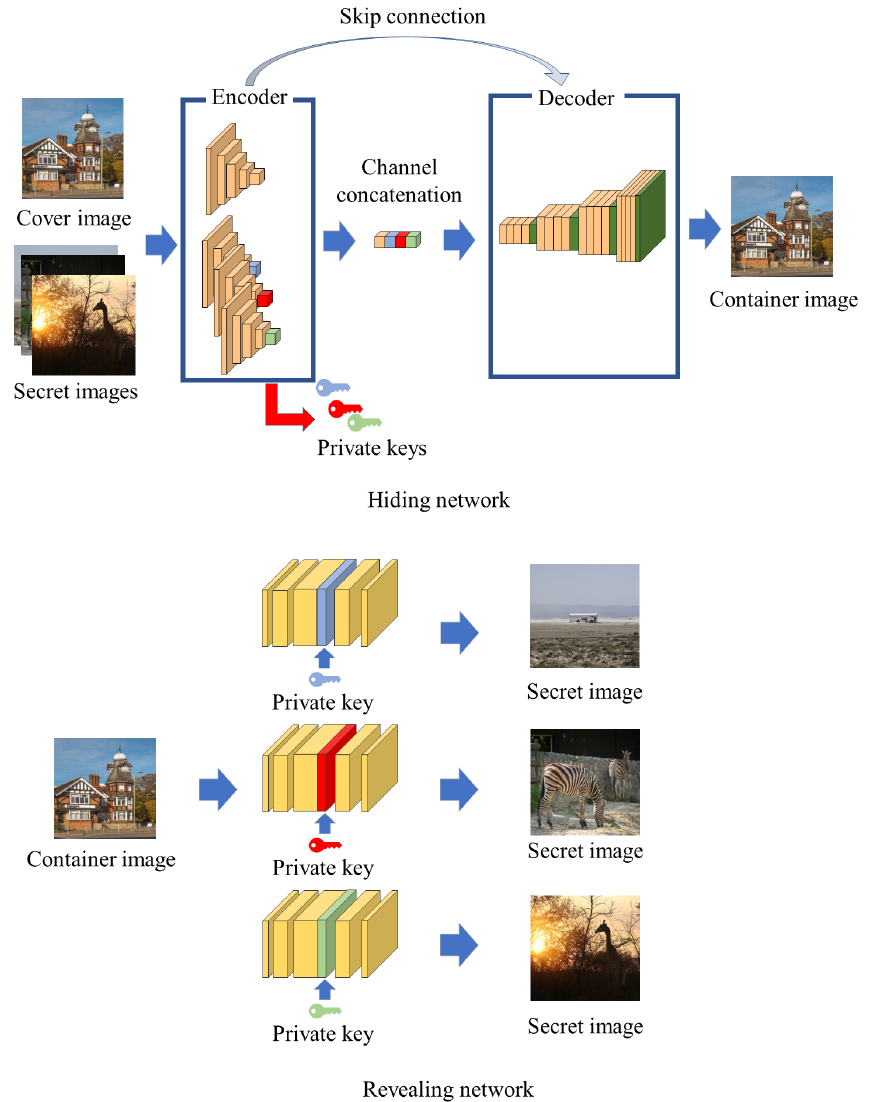
Figure 2. Overall pipeline of our steganography model. In the hiding network, the encoder takes a cover image and secret images as inputs and produces visual features for each image. Then decoder takes the concatenated visual features and produces a container image. The visual features of secret images are used as private keys. The revealing network takes a container image and a query private key as inputs then extracts a hidden secret image corresponding to the query private